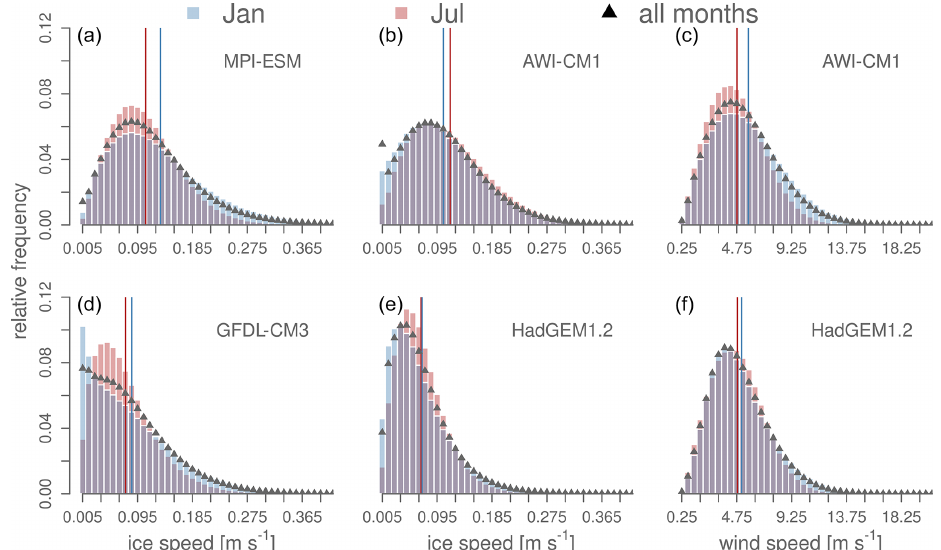
Figure 2. Relative frequency distribution for ice drift speed (a, b, d, e) and near-surface wind speed (c, f) on the common subset and only including days with SIC ≥ 0 . 15 and SIT ≥ 1mm, based on the respective control simulation. Blue bars show data for all January months in the control run, red bars for July, and black triangles for all months. The blue (red) vertical lines show the mean speed for January (July). The bin size is 0 . 01ms − 1 for ice speed and 0 . 50ms − 1 for wind